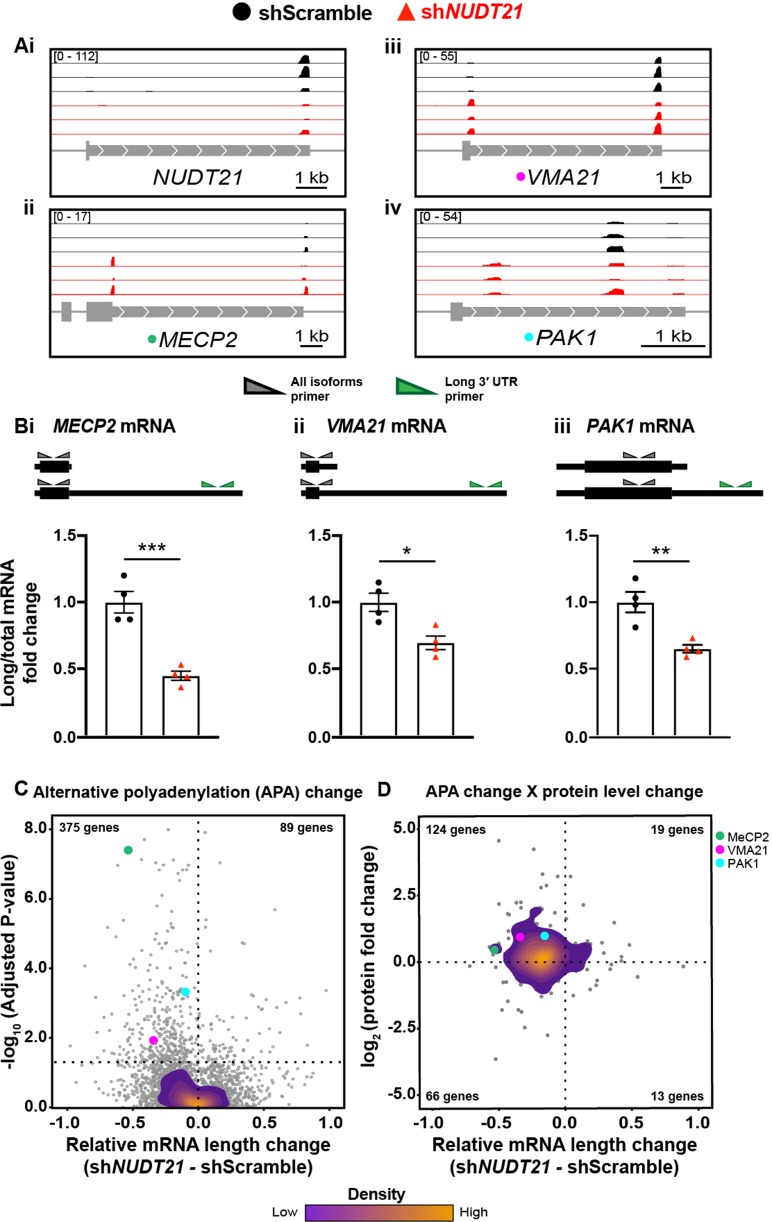
NUDT21 depletion induces aberrant alternative polyadenylation and altered protein levels.(A)(i) Poly(A)-ClickSeq (PAC-seq) track showing reduced NUDT21 and (ii-iv) PAC-seq tracks showing altered alternative polyadenylation in example genes MECP2, VMA21, and PAK1. n = 3/treatment. Peaks are 3′ end sequencing reads. Multiple peaks in a gene indicate multiple mRNA isoforms with different cleavage and polyadenylation sites. Bracketed numbers show counts per million; kb stands for kilobases. (B) Schemata of the mRNA isoforms identified by PAC-seq for MECP2, VMA21, and PAK1 (top). Triangles show the binding sites of the qPCR primers used to validate the PAC-seq results. The gray primers detect all mRNA isoforms for the target gene, whereas the green primers only detect the isoform with the longest 3′ UTR. Gapdh-normalized RT-qPCR quantification showing relatively less of the long isoforms in the shNUDT21-infected neurons (bottom) for MECP2, p=0.0007 (i), VMA21, p=0.01 (ii), and PAK1, p=0.005 (iii). Error bars indicate SEM. Data analyzed by unpaired, two-tailed t-test. (C) Volcano plot showing relative mRNA length change in shNUDT21-infected neurons compared to shScramble-infected controls. The horizontal, dashed line shows Padjusted = 0.05, n = 3/treatment. NUDT21 loss in neurons predominantly results in shorter mRNAs (p<0.0001, two-tailed chi-square test). >90% of reads are in 3′ UTRs (Figure 6—figure supplement 1A). Principle component analysis (PCA) shows sample separation by treatment (Figure 6—figure supplement 1B). Distal cleavage sites of NUDT21-regulated mRNAs are enriched for the CFIm25 binding motif, UGUA, in mRNAs that shorten after NUDT21 knockdown, but not in non-target mRNAs (Figure 6—figure supplement 1C). (E) Mass spectrometry quantification of protein level fold change for genes with significantly altered APA (Padjusted <0.05). mRNA shortening predominantly results in increased protein levels (p<0.0001, two-tailed conditional chi-square test). Source files for the PAC-seq and mass spectrometry quantification data are available in Figure 6—source data 1. *p<0.05; **p<0.01; ***p<0.001.Figure 6—source data 1.RNA length and protein level changes in genes with misregulated APA following NUDT21 inhibition in human neurons.Alternative polyadenylation (APA), likelihood ratio (lr), degrees of freedom (df), first polyadenylation site (F), middle/center polyadenylation site (M), last polyadenylation site (L) mass spectrometry (MS), fold change (FC), intellectual disability (ID), probability of loss of function intolerance (pLI).